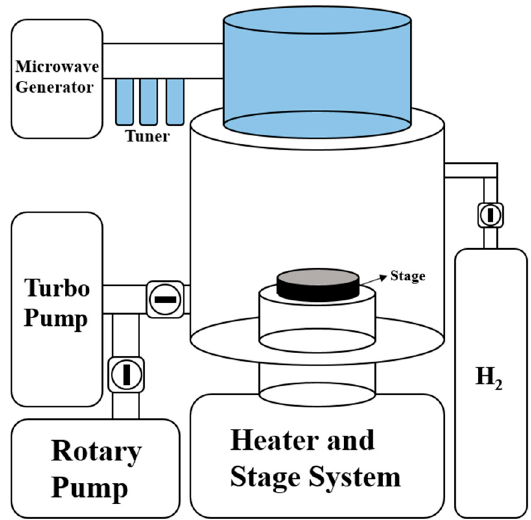
Figure 2. Schematic diagram of the PECVD used in this study to synthesize the ZnO NS using the H 2 reduction process. Table 3. Details of the H 2 reduction process conditions.